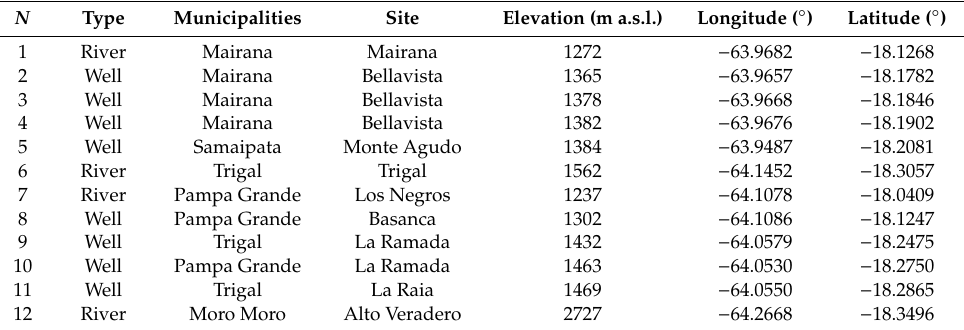
Table 9. Locations of water points